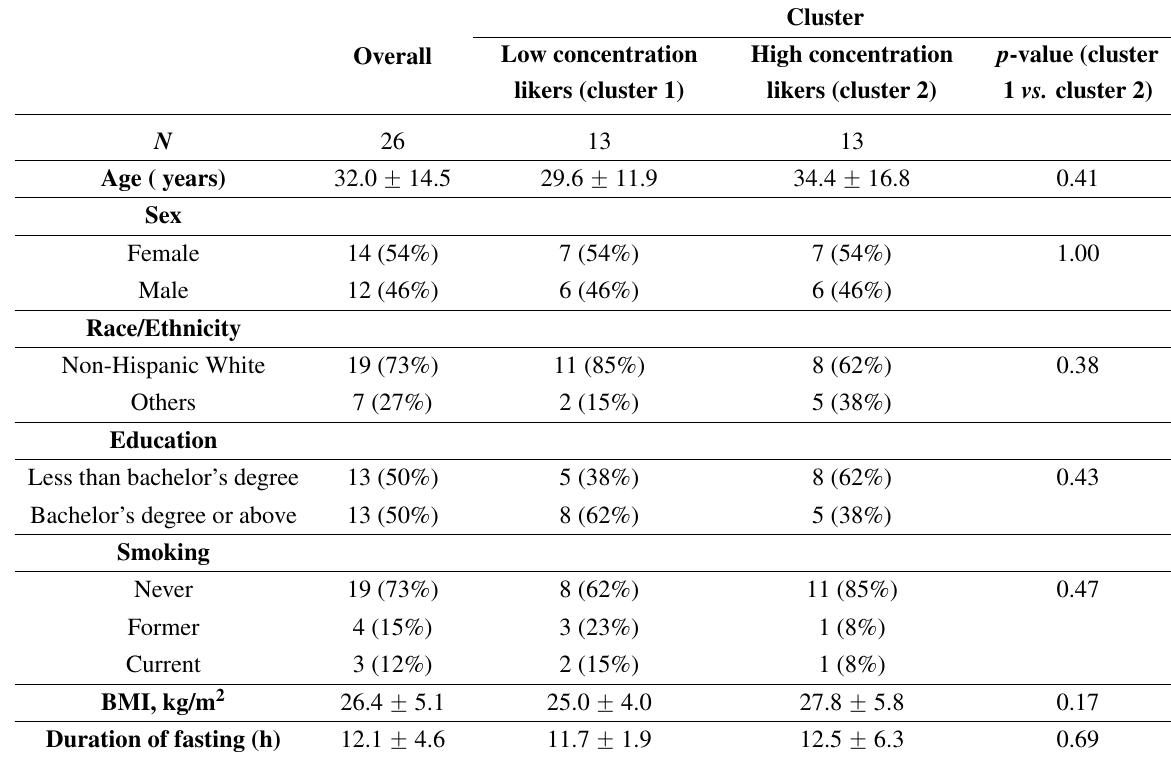
Table 1. Characteristics of the